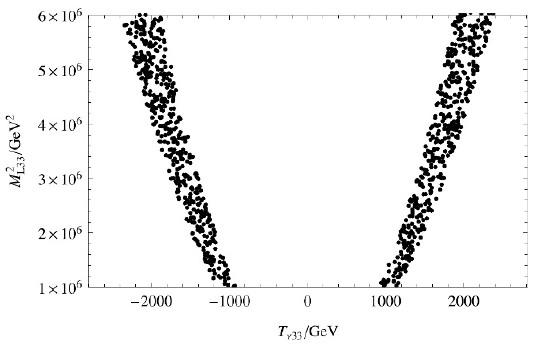
Figure 3 . The allowed results of the relic density in the plane of M 2